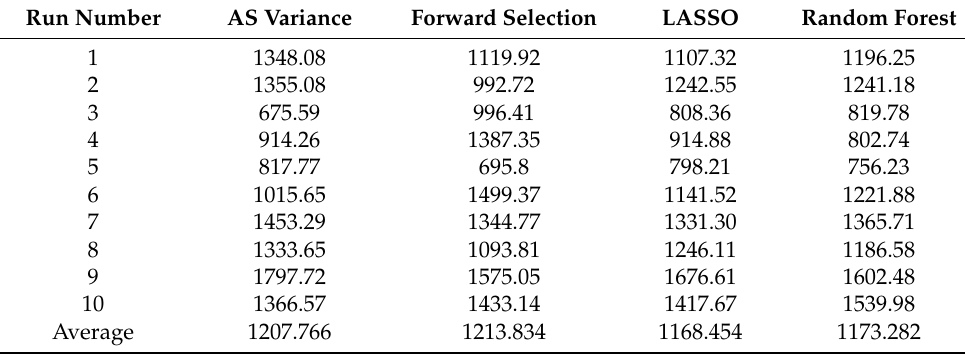
Table A1. MSPEs of three selection approaches to modeling AS intake 1 . Run Number AS Variance Forward Selection LASSO Random Forest 1